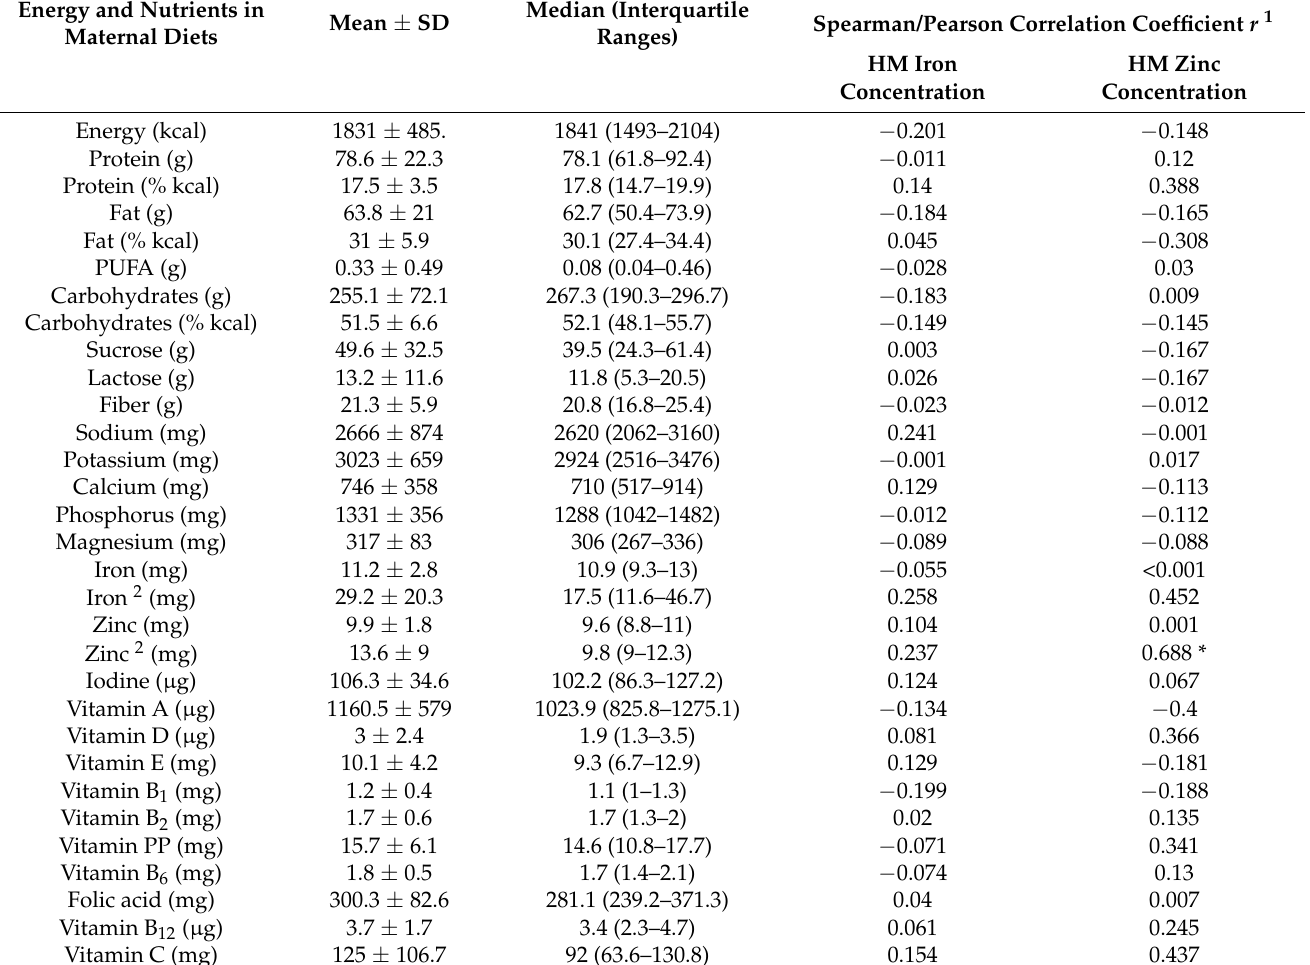
Table 5. Correlations between maternal diet and supplementation and concentrations of iron and zinc in HM.